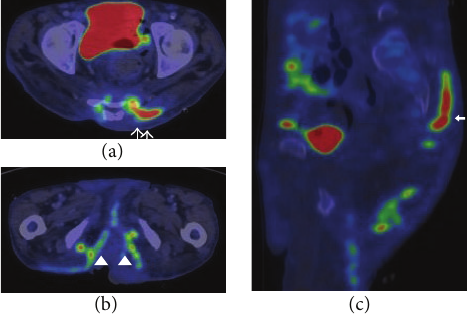
Figure 7: PET-CT performed after surgical excision of the right squamous cell carcinoma in the right thigh with wide resection mar- gins. Note: FDG-avid foci in the perianal spaces ((b), arrowheads) and a more superior abscess collection at the left posterior back ((c), thick arrow), extending to the sacral level ((a), white